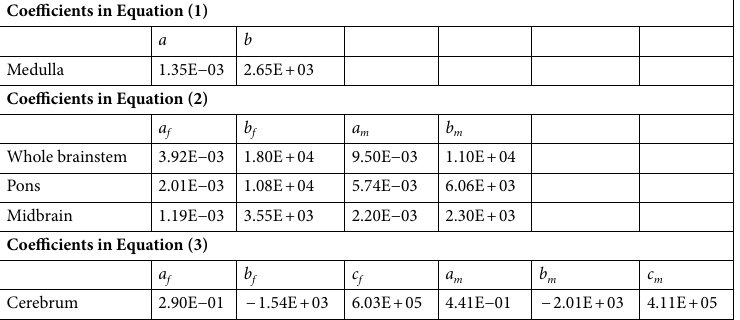
ROI Intraclass correlation coefficient (95% CI) P- value